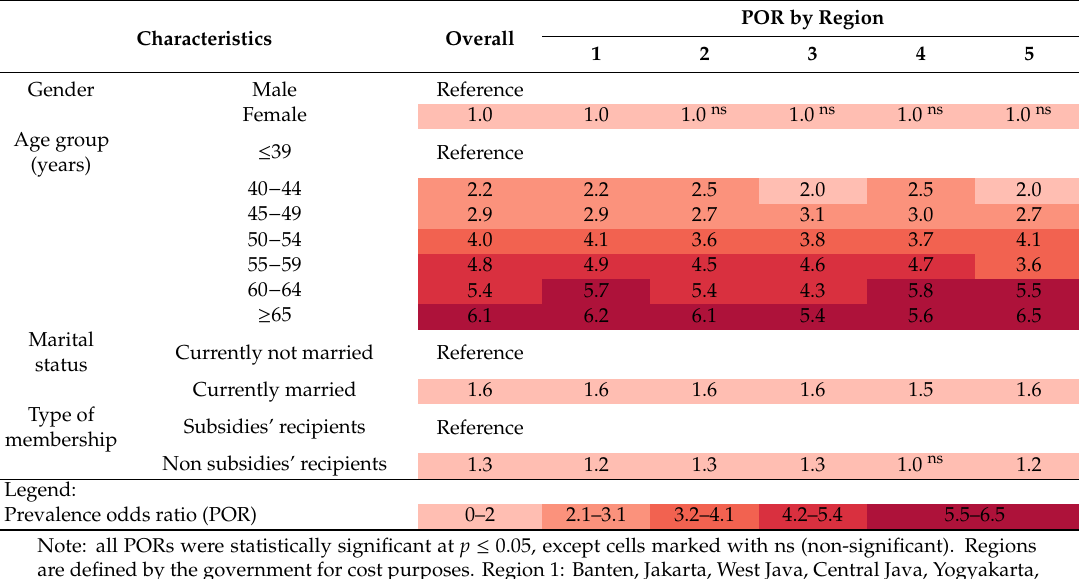
Table 2. Risks of having chronic multimorbidities according to